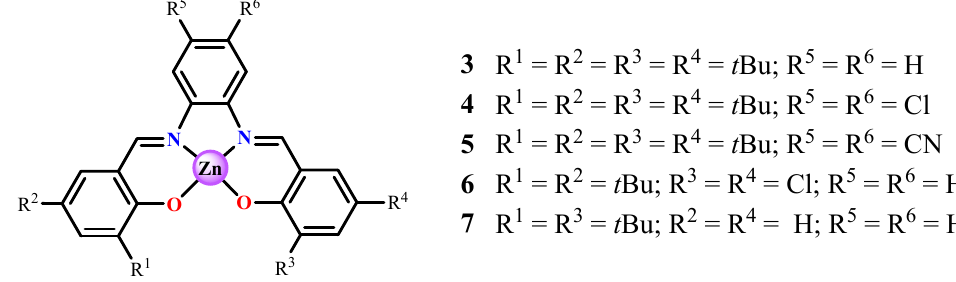
Figure 3. Molecular drawing of the H 2 - t -salen ligand ( left ) and crystal structure of the Zn 2 ( t -salen) 2 complex 2 ( right ). Adapted from Ref. [19].